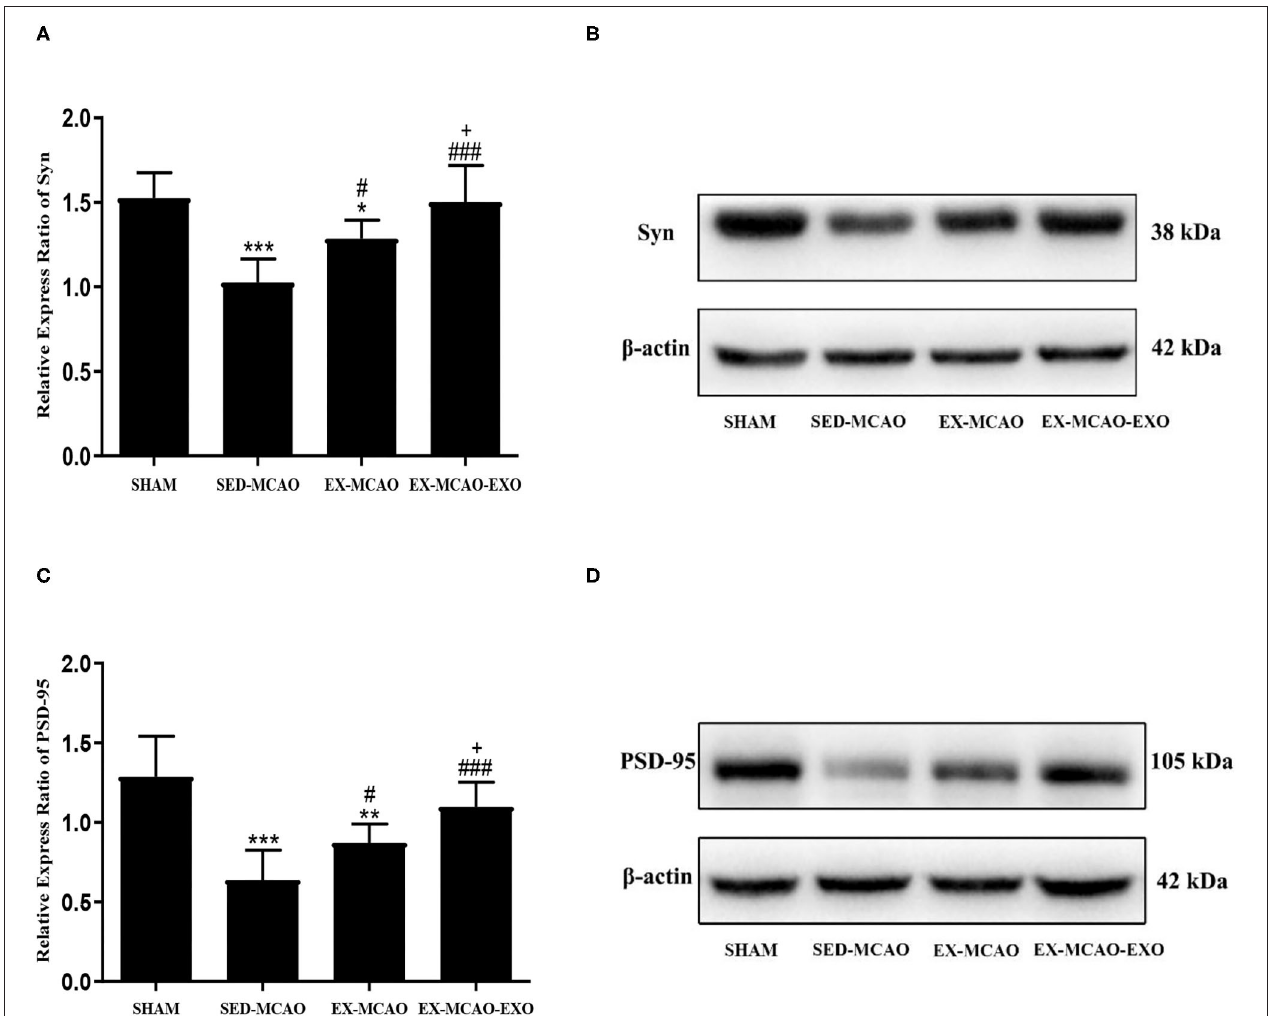
FIGURE 5 | The relative level of the synaptic plasticity-associated protein expression in the peri-infarcted region of the brain. (A) Relative level of the Syn protein. (B) Western blotting was used to detect Syn expression. (C) Relative level of the PSD-95 protein. (D) Western blotting was used to detect PSD-95 expression. * p < 0.05, ** p < 0.01, and *** p < 0.001 compared with the corresponding SHAM group. # p < 0.05 and ### p < 0.001 compared with the corresponding SED-MCAO group. + p < 0.05 compared with the corresponding EX-MCAO group. Means ± standard deviations, n =